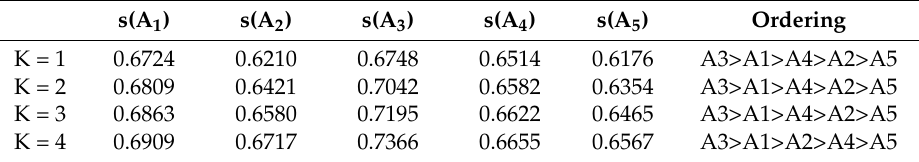
Table 7. Ranking results for different operational parameters of the IV2TLPFWDMSM